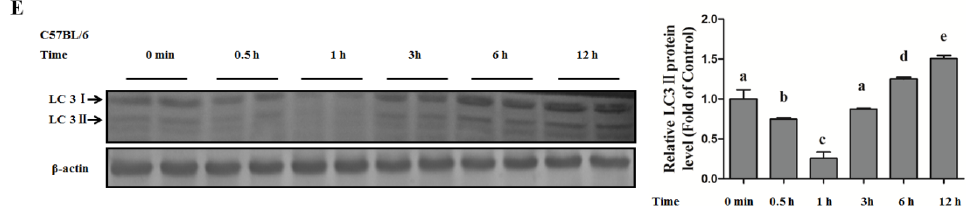
Figure 4. Time course-dependent regulation of insulin on hepatic autophagy. Hepatocytes were cultured within EBSS medium for 12 h, and then exposed to insulin (200 nM) for the indicated duration. Total lysates of cells were subjected to immunoblotting assay for LC3. Plasmid (containing mRFP-GFP-LC3) transfection was performed 12 h before EBSS intervention for autophagosome detection. For in vivo analysis of hepatic autophagy, mice were suffered to insulin injection as described in the Methods. ( A , B ) Immunoblotting assay for LC3 conversion in HepG2 cells and AML-12 cells; ( C ) The effect of insulin on autophagy was examined by fluorescence microscopy for puncta formation; ( D ) Mice plasma insulin level ( n = 5); ( E ) LC3 expression in mice liver ( n = 5). Each in vitro test was performed at least 3 times. Bars with different characters differ significantly ( p < 0.05).